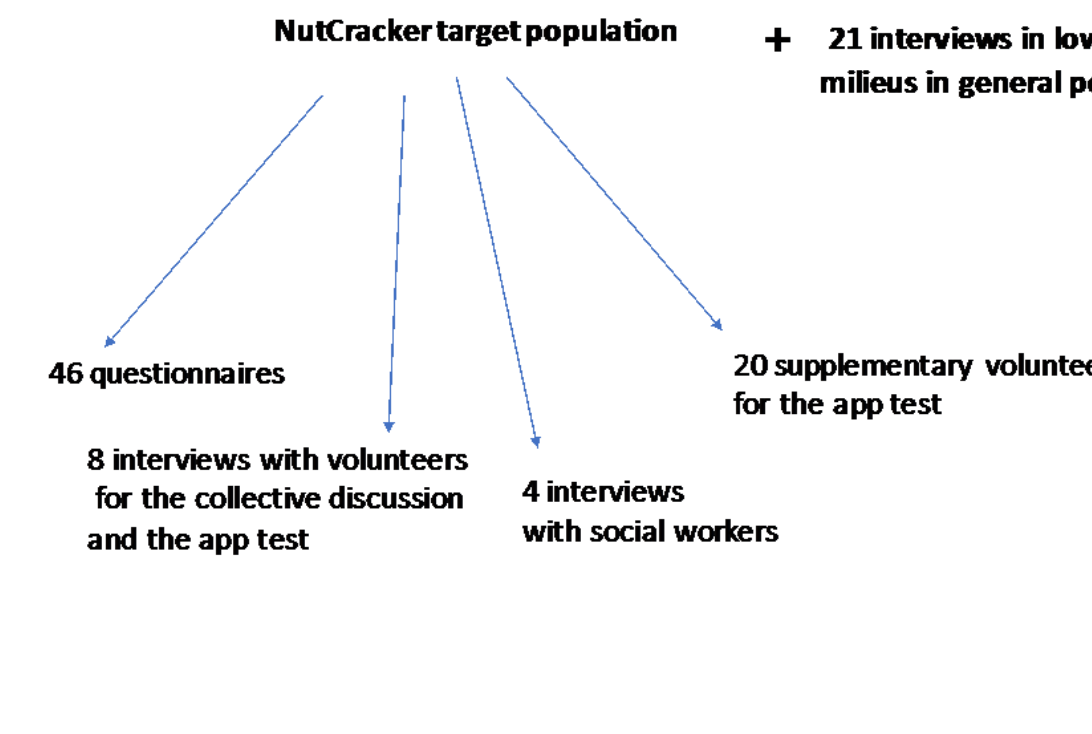
Figure 1. Subsamples of the